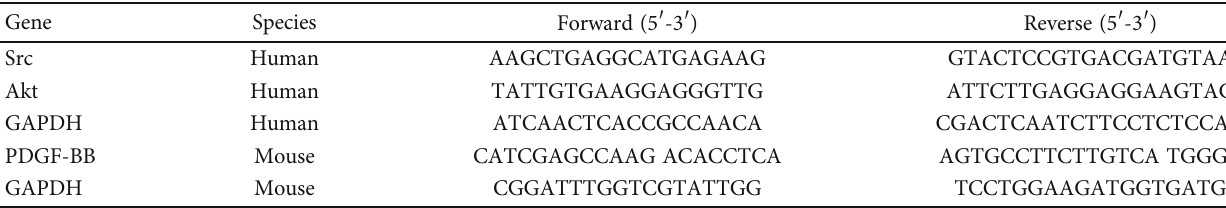
Table 2: Primers for RT-PCR.